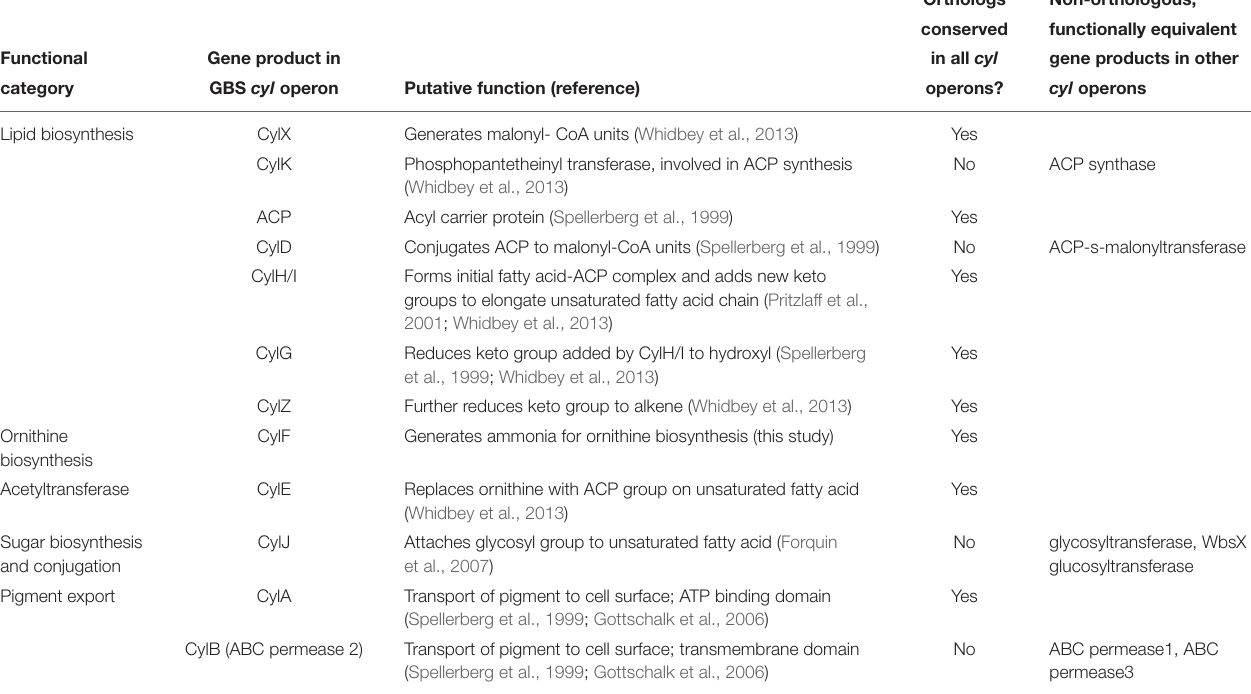
TABLE 1 | Genes in cyl operons encode proteins that fall into one of five functional